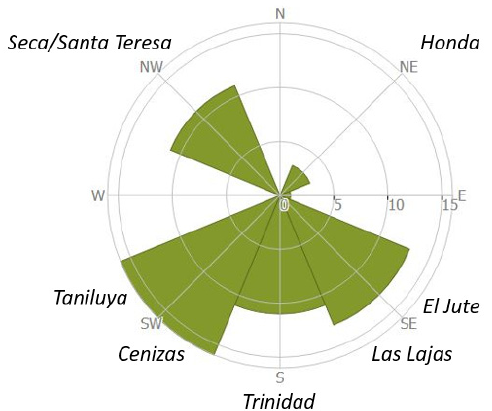
Figure 5. Rose diagram showing the directionality of the PDC events over the ~15-year study period. PDC directionality was determined using both ASTER scenes and INSIVUMEH reports. Sixteen PDCs traveled southwest (Taniluya and Cenizas barrancas), 13 traveled southeast (El Jute and Las Lajas barrancas), 11 traveled south (Trinidad barranca), and 11 traveled northwest (Seca / Santa Teresa barrancas), while only 3 traveled to the northeast (Honda barranca).